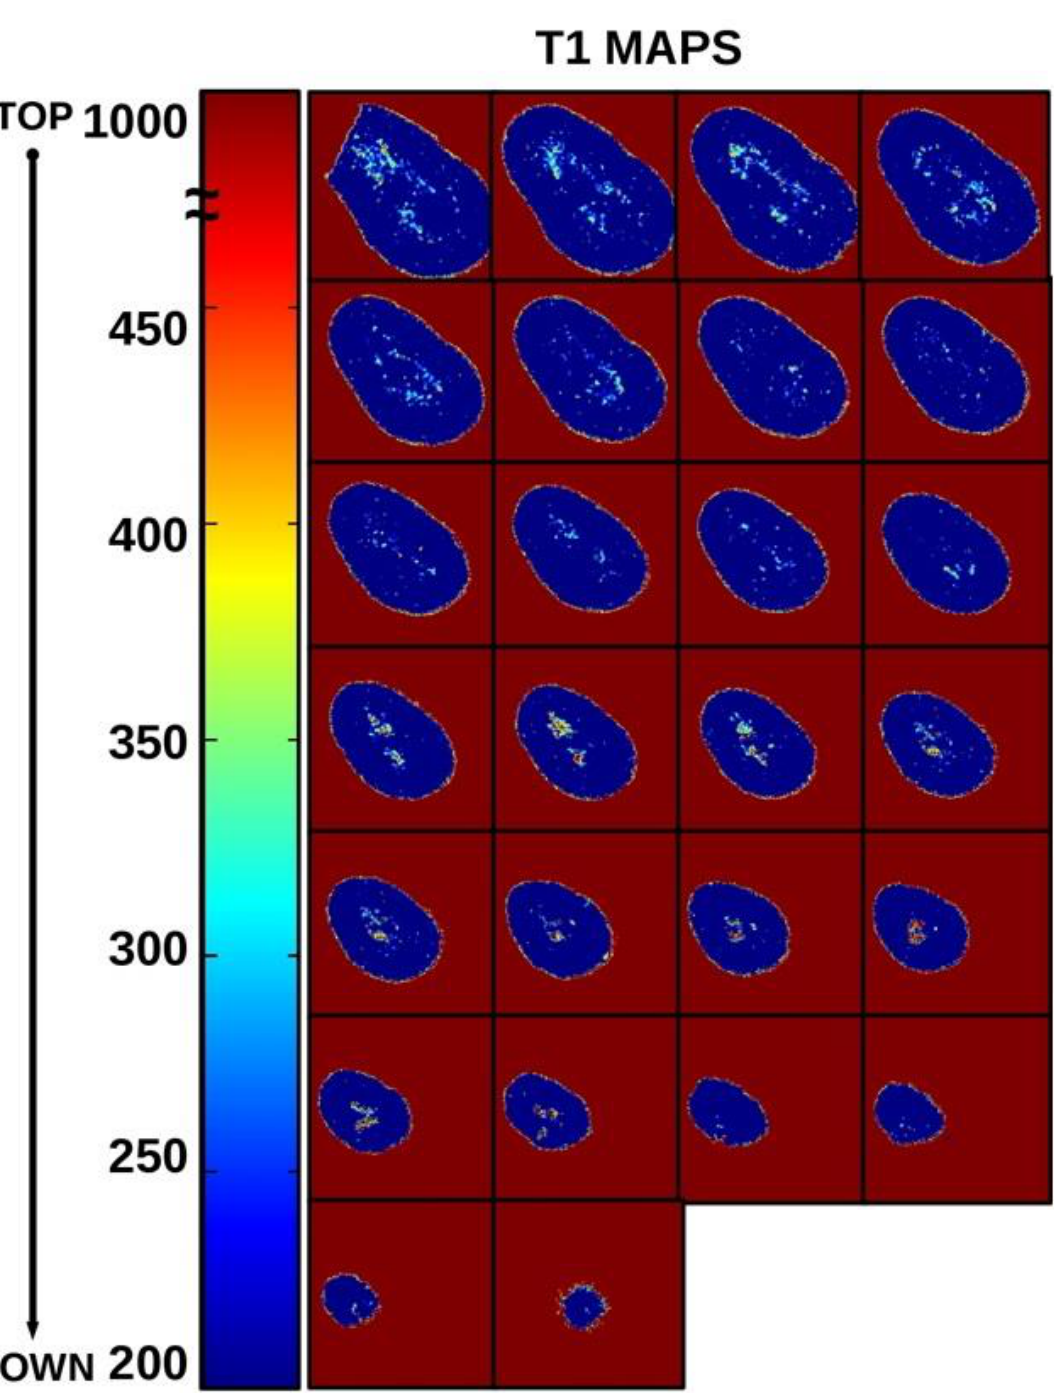
Figure 5. T1 map axial slices. Primary dentine is characterized by T1 values around 200 ms or less, and free water has T1 values more than 1000 ms. All voxels with T1 values ranging between 200 and 1000 ms indicate zones of tertiary dentin and/or incomplete filling zones. Comparing the images in this figure with those shown in Figure 1, it is possible to highlight the complementary information provided by T1 mMRI maps and CBCT images.